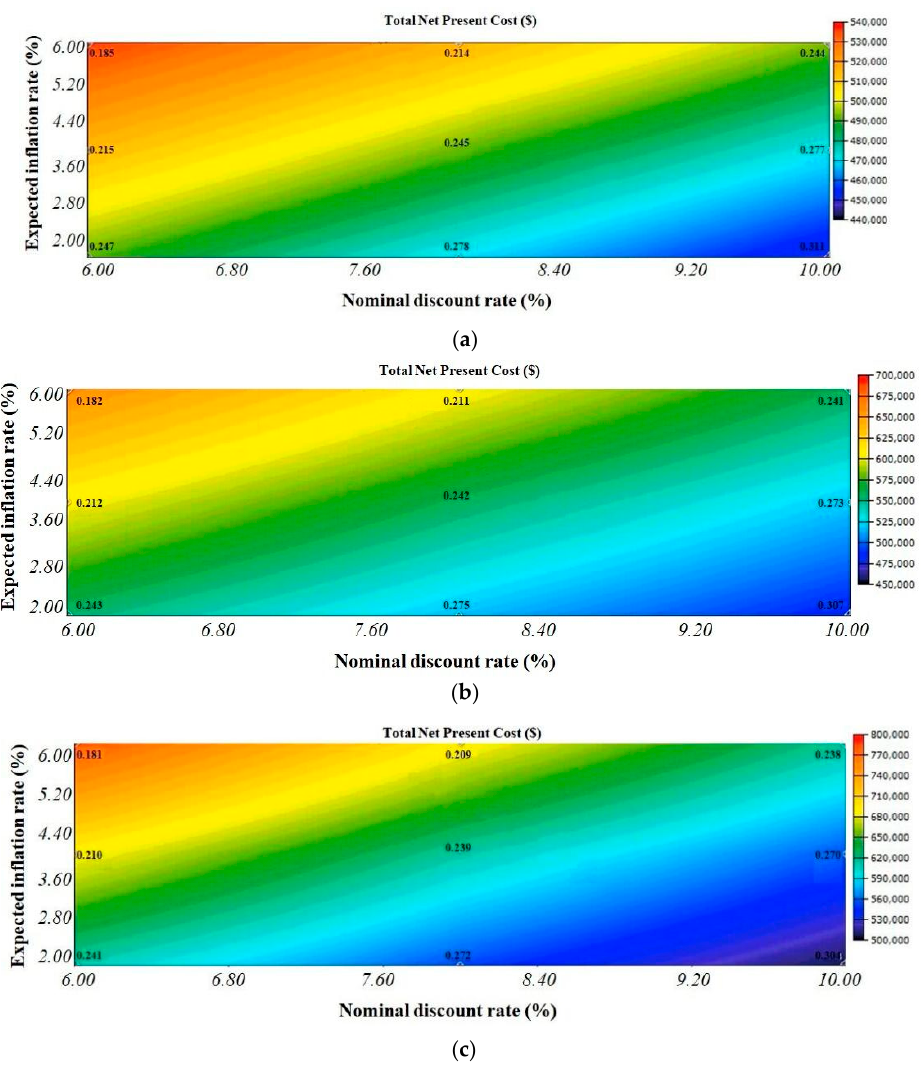
Figure 21. Variation in NPC concerning the inflation rate and discount rate with project lifetime of ( a ) 20 years, ( b ) 25 years, and ( c ) 30 years. ( a ) 20 years, ( b ) 25 years, and ( c ) 30